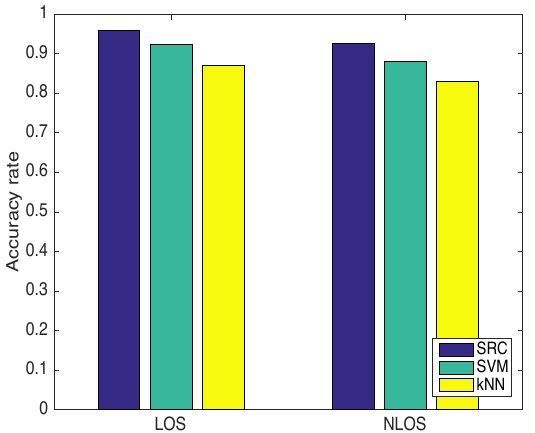
Figure 7. Classification method comparison, Support Vector Machine (SVM); k-Nearest Neighbor